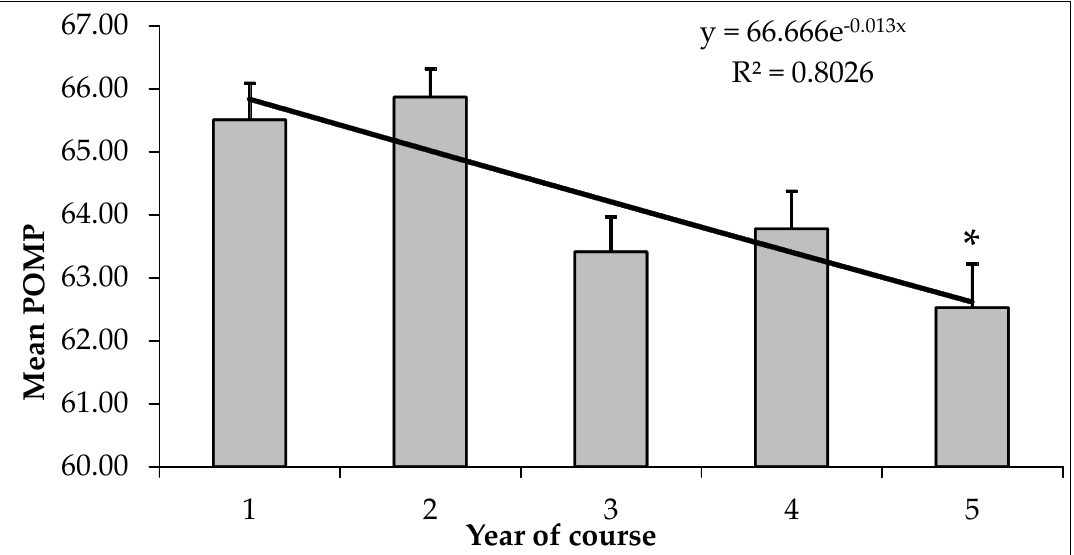
Figure 1. Comparison of mean ± standard error (SE) percentage of maximum possible (POMP) score of the Animal Attitude Scale (AAS) by year of course. Data were represented determining an exponential regression model equation and analyzed using the Kruskal–Wallis test with Bonferroni’s correction (* = significant difference vs year 1 and 2; p = 0.001). Fig. 2, a/b